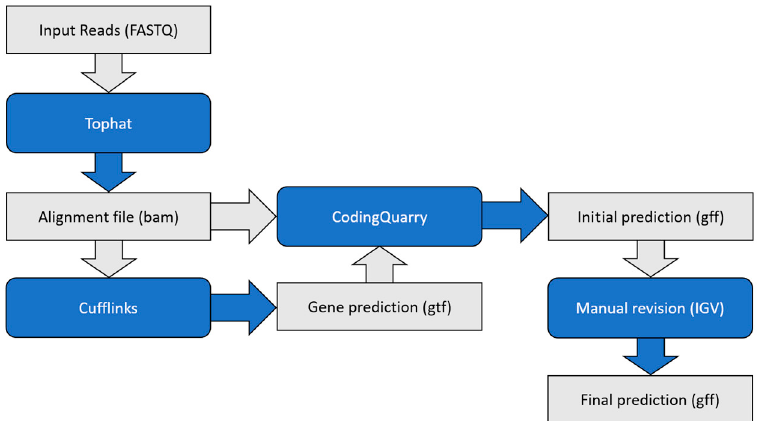
Figure 1. Gene prediction workflow. Reads were first aligned against the genome sequence using Tophat software. The alignment file (BAM) generated was then used to predict gene models (gtf) using Cufflinks software. Finally, both the alignment file and the gene models were loaded to CodingQuarry to generate the initial gene models, which are manually revised to generate a final prediction (gff).